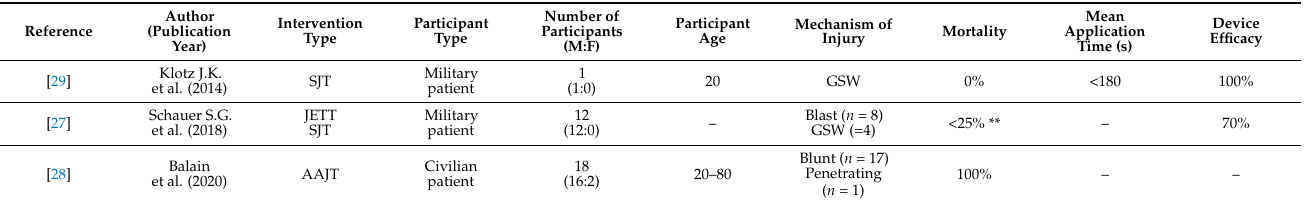
Table 4. Summary of junctional tourniquet study characteristics, patient demographics, and outcome measure results in civilian and military trauma patients.